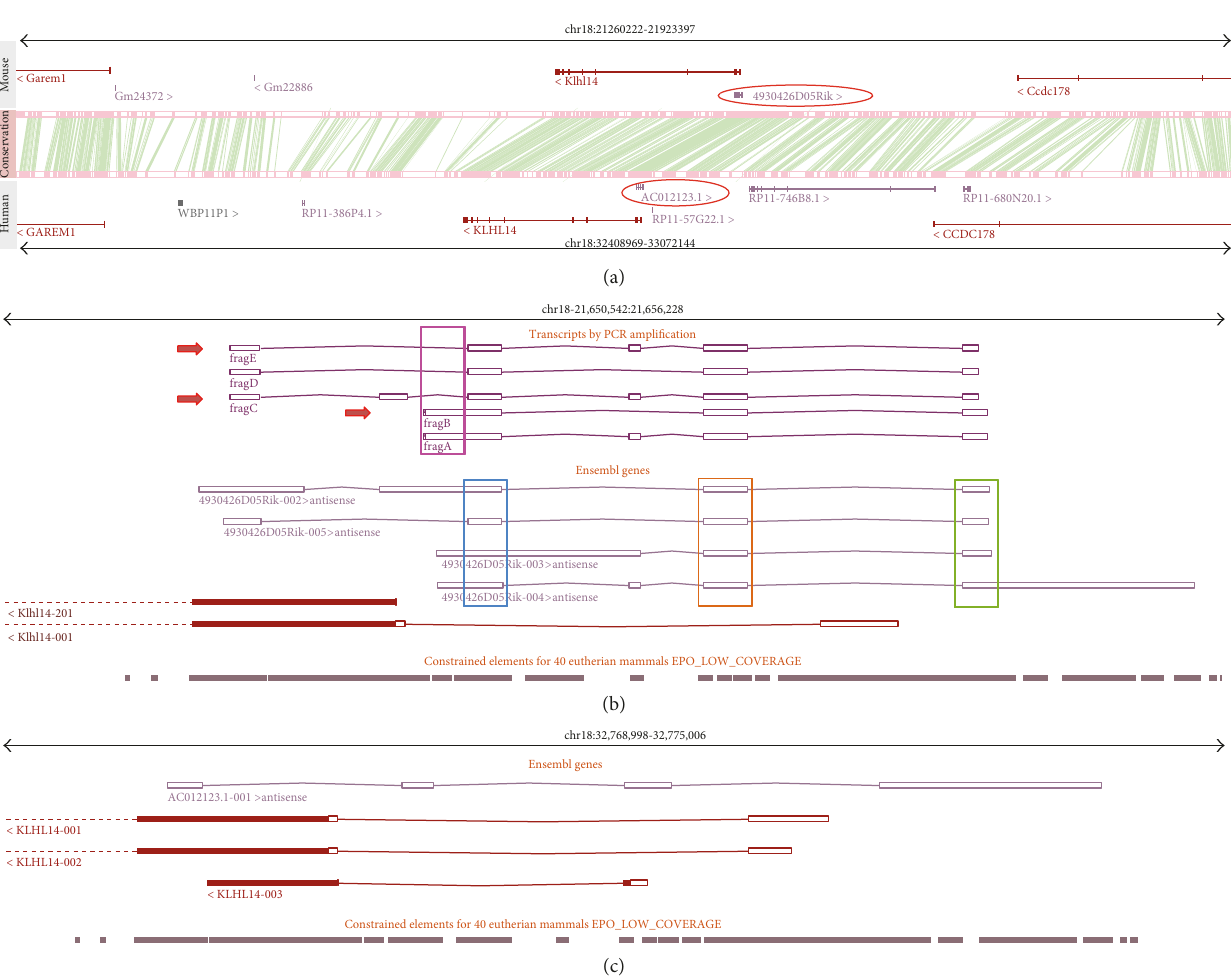
Figure 1: Genomic context of the Klhl14 S/AS pair in mouse and human. In (a), two genomic segments from mouse and human containing the Klhl14 S/AS pair and fl anking genes are displayed. The regions are clearly syntenic, and the presence of an antisense noncoding gene (red circle) is conserved in both species. Pink boxes indicate conserved blocks, and green lines represent their correspondences. In (b) and (c), the slices are zoomed in to show the entire AS genes and the Klhl14 gene portion in overlap for the mouse (b) and human (c) genome, respectively. The constrained elements displayed as grey boxes represent regions of sequence conservation in mammals according to Ensembl. In (b), the regions shared by all the transcripts are indicated by the blue, orange, and green boxes. Fragment A to fragment E represent the isoforms identi fi ed in this study with the new ones indicated by the red arrows. The region in the pink rectangle is ampli fi ed exclusively with one set of oligos.